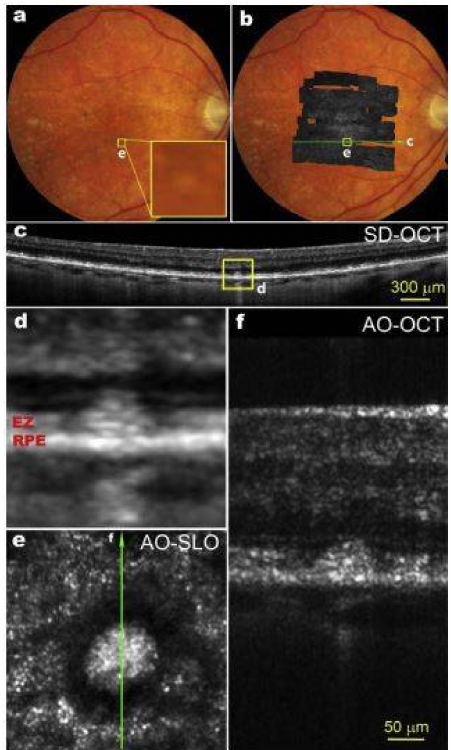
Figure 3. ( a ) Color fundus photograph of an 83-year-old patient with intermediate non-neovascular AMD; The yellow box ( e ) is 300 µ m on each side; ( b ) AOSLO montage overlaid on the fundus photo; ( c ) A SD-OCT B-Scan taken along the green line in panel b shows that this subretinal drusenoid deposit (SDD) has broken the photoreceptor EZ band; ( d ) Magnification of boxed area in panel c ; ( e ) The AOSLO image of the boxed retina in panels a and b . The bright spots outside the hyporeflective annuls are photoreceptors; ( f ) AO-OCT of the SDD, as indicted by the green line in panel e . Images ( d – f ) share the same scale bar. SD-OCT images are in logarithmic grey scale. AO-OCT is in linear grey scale [93].